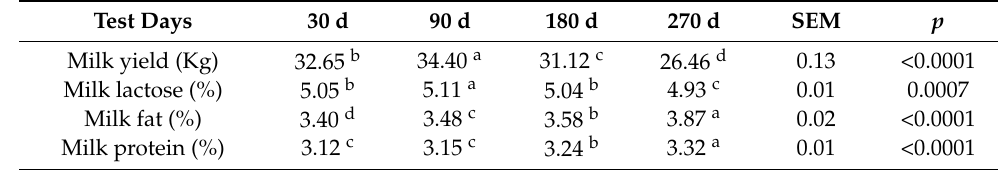
Table 1. Milk yield, milk lactose, milk fat and milk protein at different lactation stages (means ±